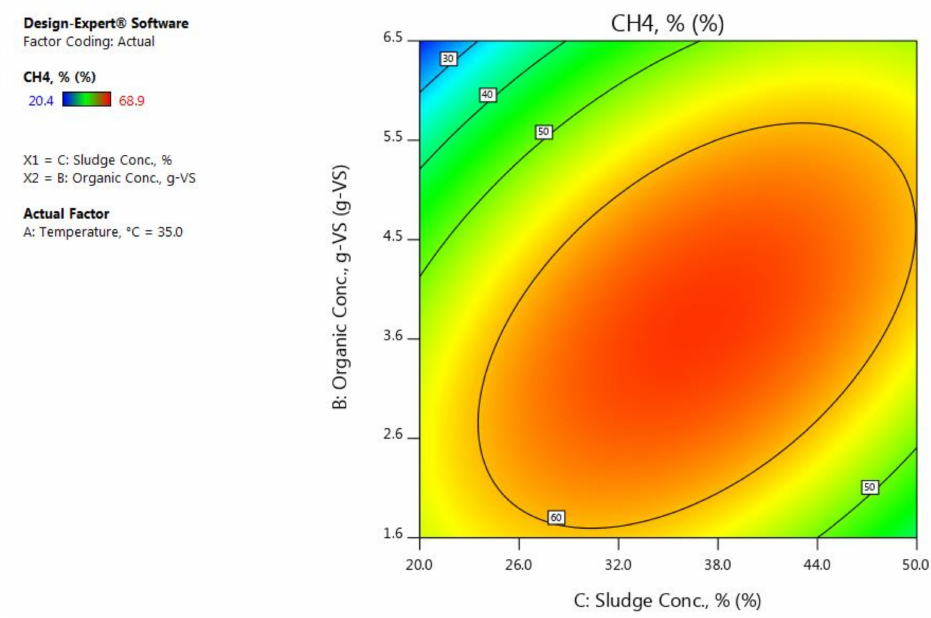
Figure 6. A contour plot illustrating the influence of (BC) on the CH 4 %.